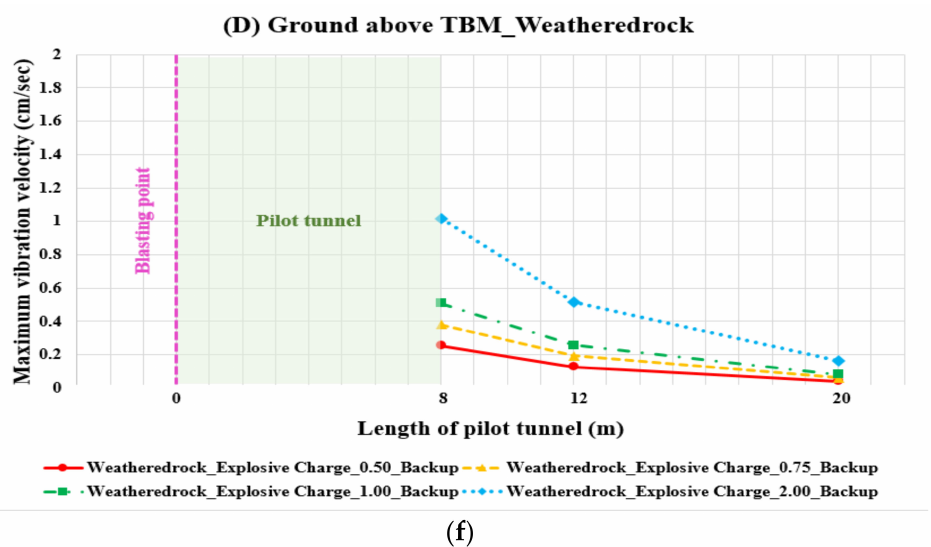
Figure 6. Analysis results for vibration velocity according to rock type and powder factor (mea- surement points C and D): ( a ) TBM (hard rock), ( b ) TBM (soft rock), ( c ) TBM (weathered rock), ( d ) ground above TBM (hard rock), ( e ) ground above TBM (soft rock), and ( f ) ground above TBM (weathered